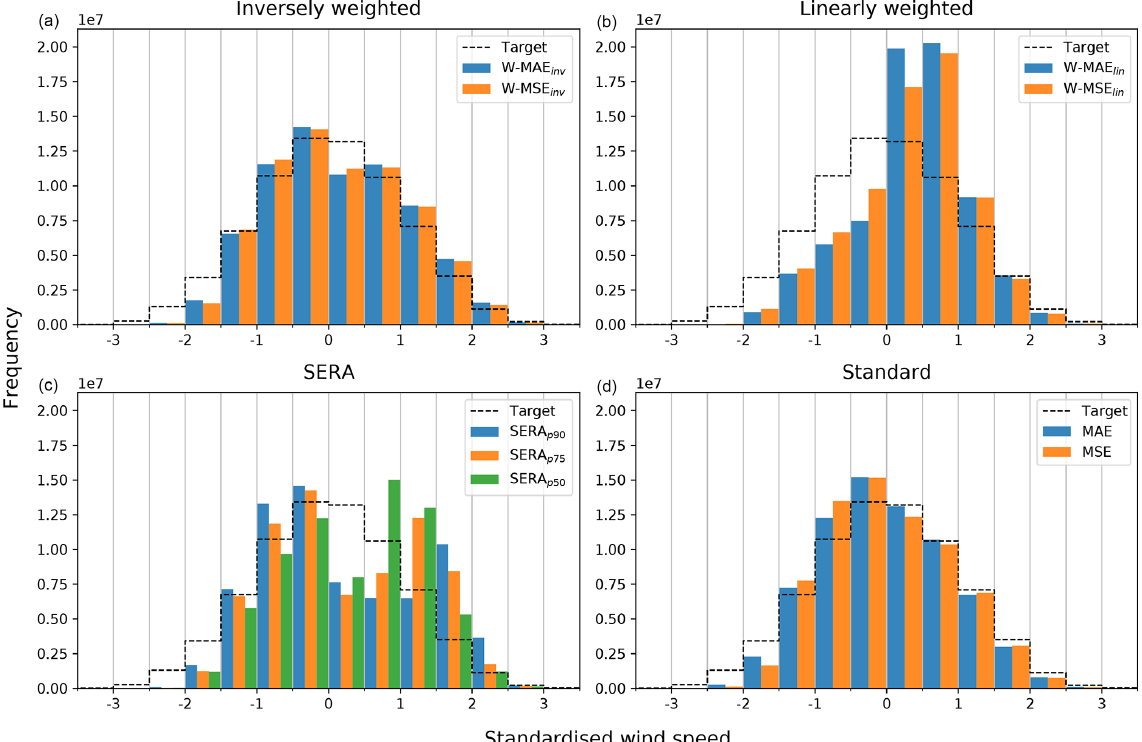
Figure 7. Histograms of forecast distributions of the ConvLSTM trained with the various different loss functions investigated in this paper, compared to the underlying distribution of the observations in the test set, which are labelled as “Target” (dotted black line). (a) The inversely weighted losses. (b) The linearly weighted losses. (c) The SERA loss with different primary control points (with the secondary control point fixed at p 99 ). (d) The standard MAE and MSE losses. The distributions were sampled with a step size of 0.5 (standardised wind